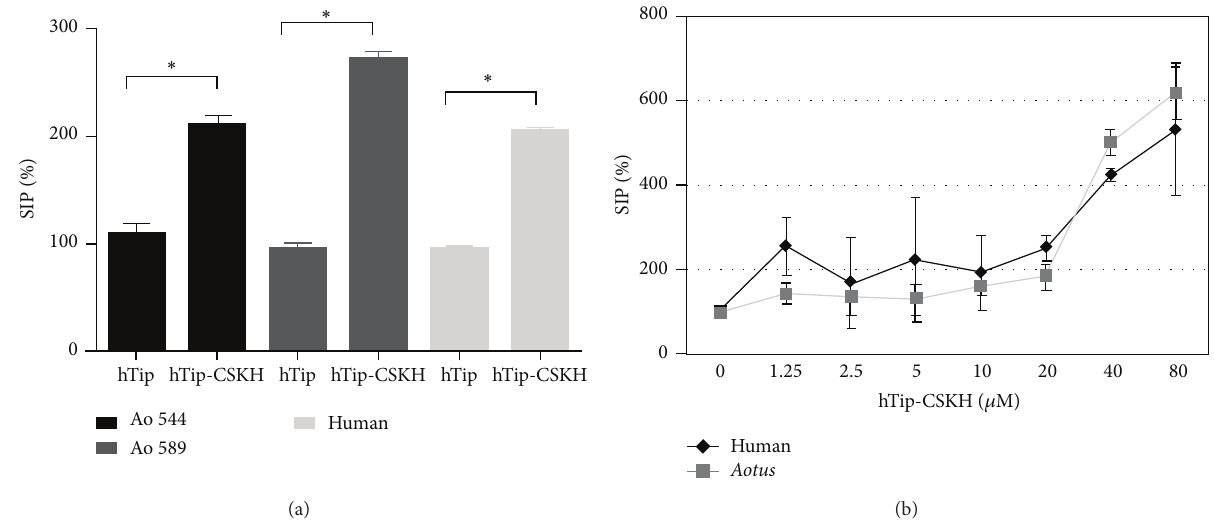
Figure 1: hTip-CSKH induced cell proliferation in human and Aotus cells. (a) PBMC from two Aotus nancymaae and one human donor were treated with 40 𝜇 M hTip or hTip-CSKH peptides and assayed for [ 3H ] -thymidine incorporation after 48-hour treatment. (b) Human and Aotus PBMC exposed to several hTip-CSKH concentrations were assessed for [ 3H ] -thymidine incorporation after 72-hour treatment. Stimulation index percentage (SIP) is shown (see Section 2). Student’s 𝑡 -test statistically significant values ( 𝑝 < 0.05 ) are marked with asterisk ( ∗